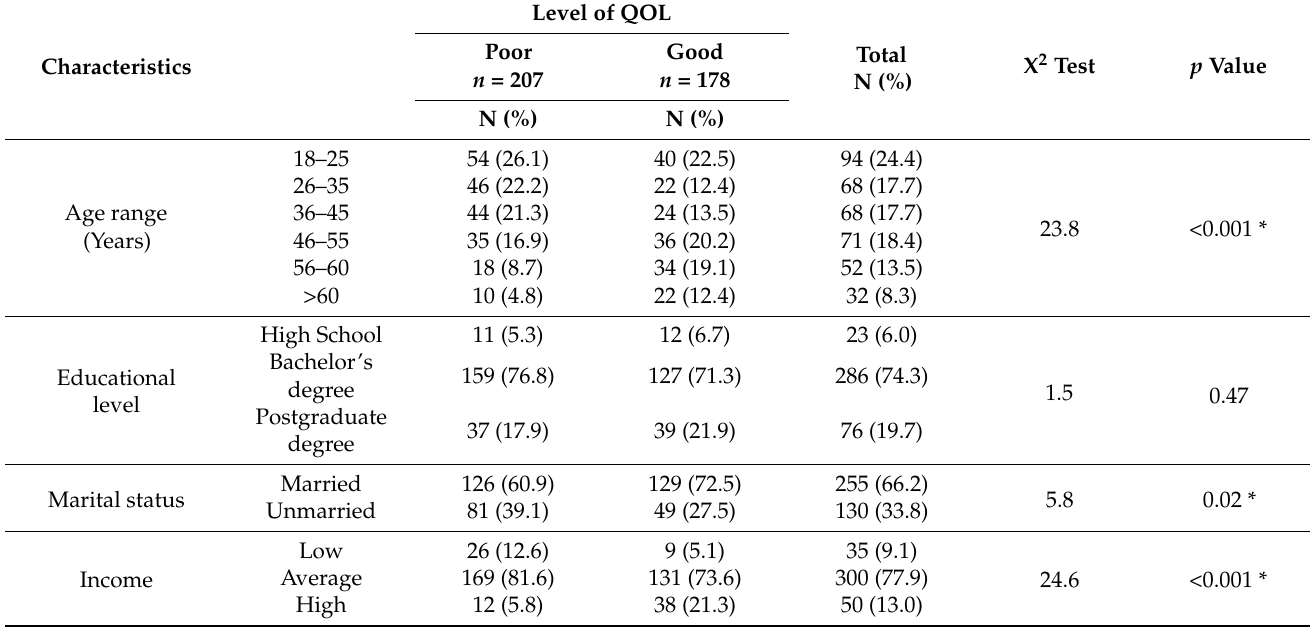
Table 4. A comparison of the personal characteristics of the respondents and their resilience based on their level of QoL (N =